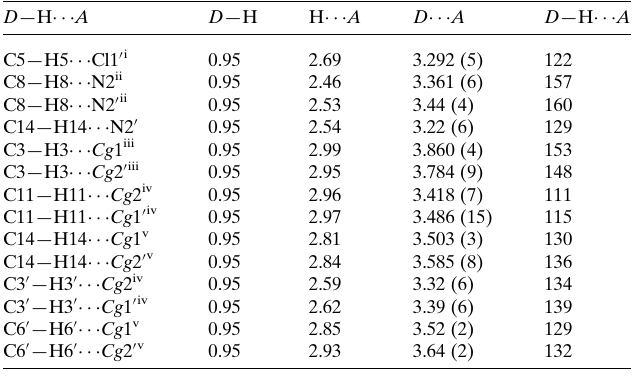
Table 1 Hydrogen-bond geometry (A˚ , (cid:4) ). Cg 1 and Cg 2 are the centroids of rings C1–C6 and C9–C14 of the major disordered component. Cg 1 0 and Cg 2 0 are the centroids of rings C1 0 –C6 0 and C9 0 –C14 0 of the minor disordered component.